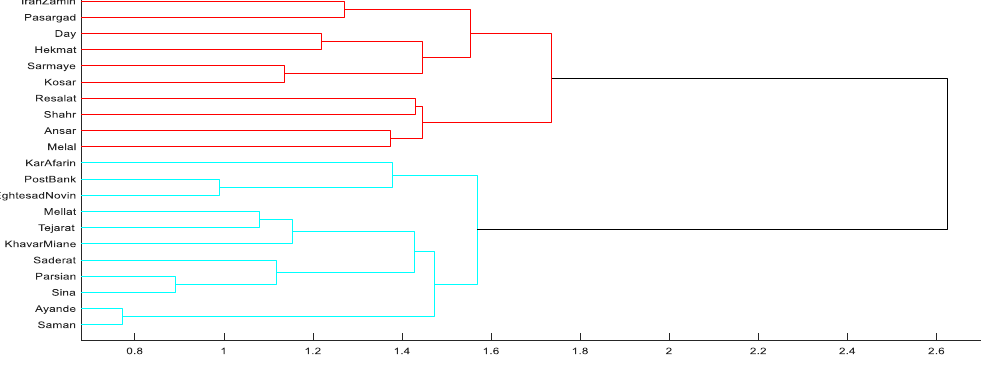
Figure 9. Comparison of Bank Clusters by Dendrogram. The high distance between clusters indicates the weak correlation between the main clusters of the banks.